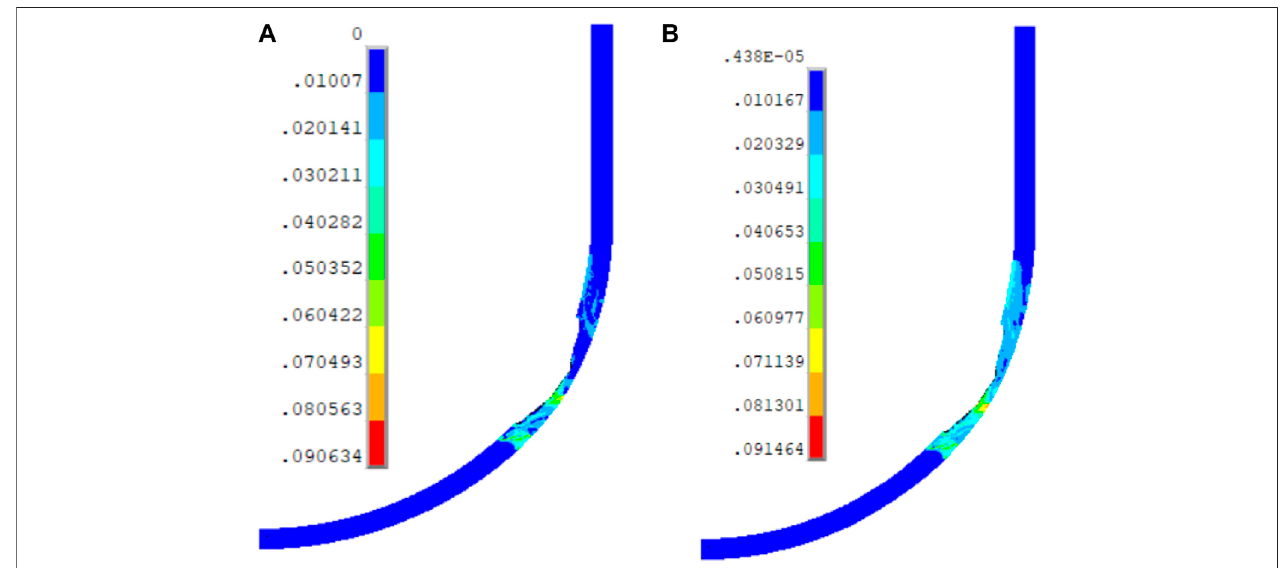
FIGURE 11 | (A) Equivalent creep strain and (B) total strain of the vessel wall at time = 6.8 h for the SBO case.